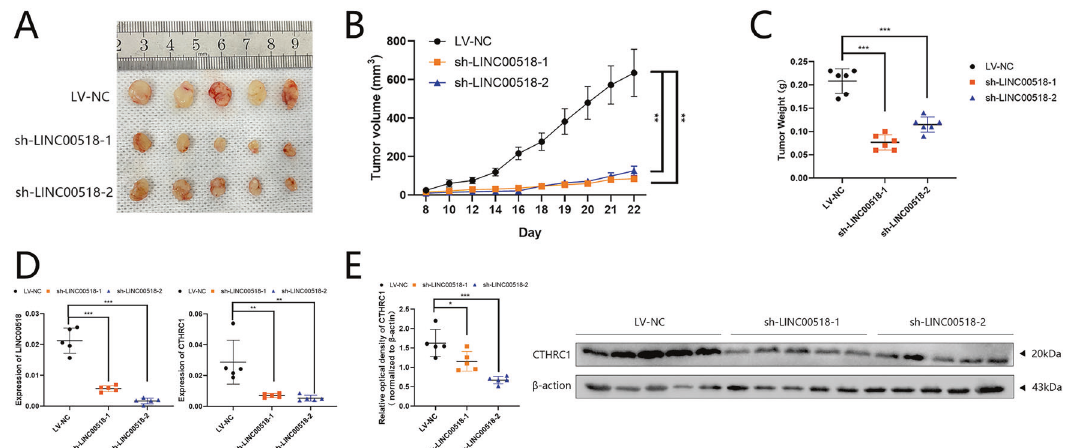
Fig. 6 Knockdown of LINC00518 inhibits LUAD tumor growth in vivo. A – C The transplantation tumor experiments showed that repression of LINC00518 expression by shLINC00518 plasmid reduced the tumorigenic ability and tumor volume of A549 cells. D The expression level of LINC00518 and CTHRC1 in tumor tissues of mice was detected by qRT – PCR. E As is shown in Western blotting that LINC00518 expression or treatment of the cells with LV-NC decreased CTHRC1 protein expression in tumor tissues of mice. All results indicate SD. (* P < 0.05, ** P < 0.01, ** *P <